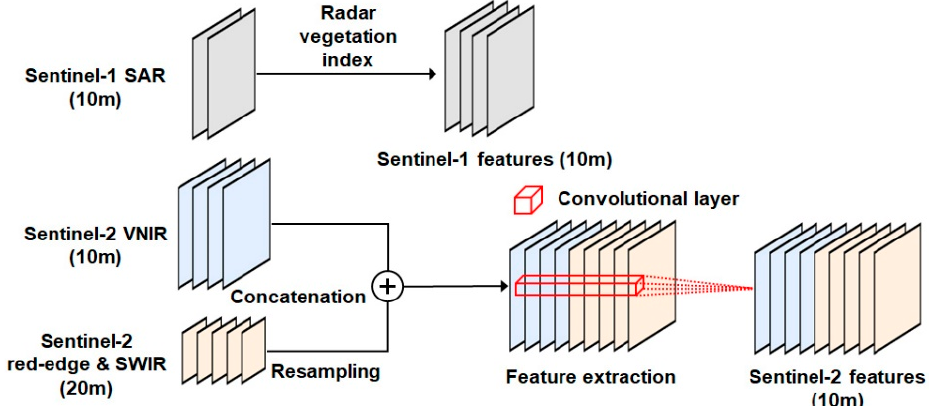
Figure 7. Feature extraction procedures from Sentinel-1 and -2 images in the representation stage.